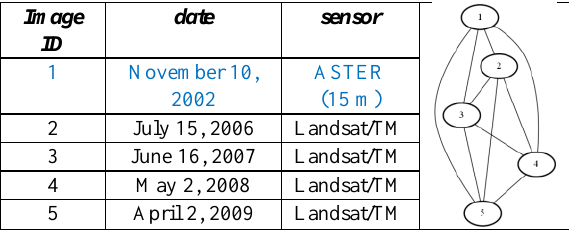
Table 2. ASTER and Landsat/TM images for the multi-sensor